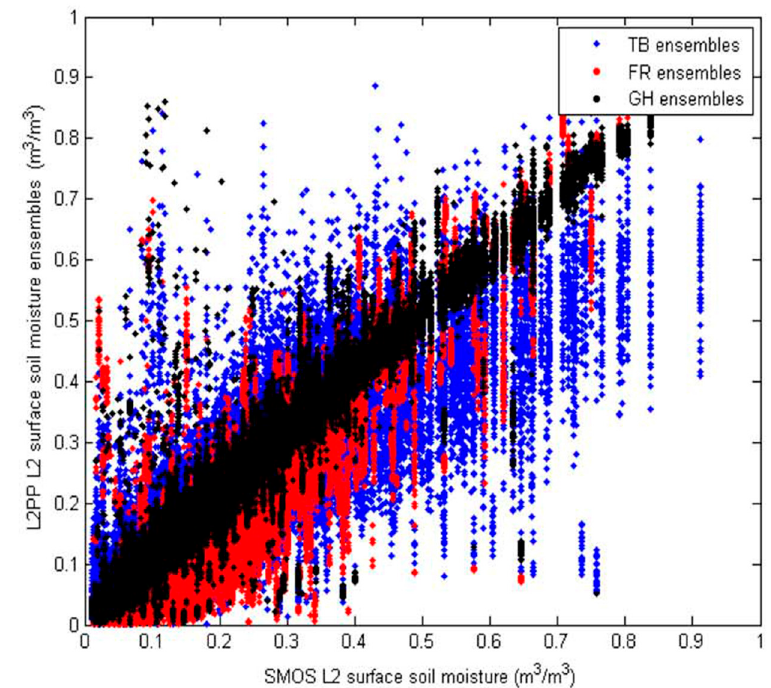
Figure 7. Different retrieval ensembles by different perturbation regimes: GH stands for a random perturbation of geo-physical parameters; TB for brightness temperature; and FR for land cover fraction (or sub-pixel land surface information) [18].